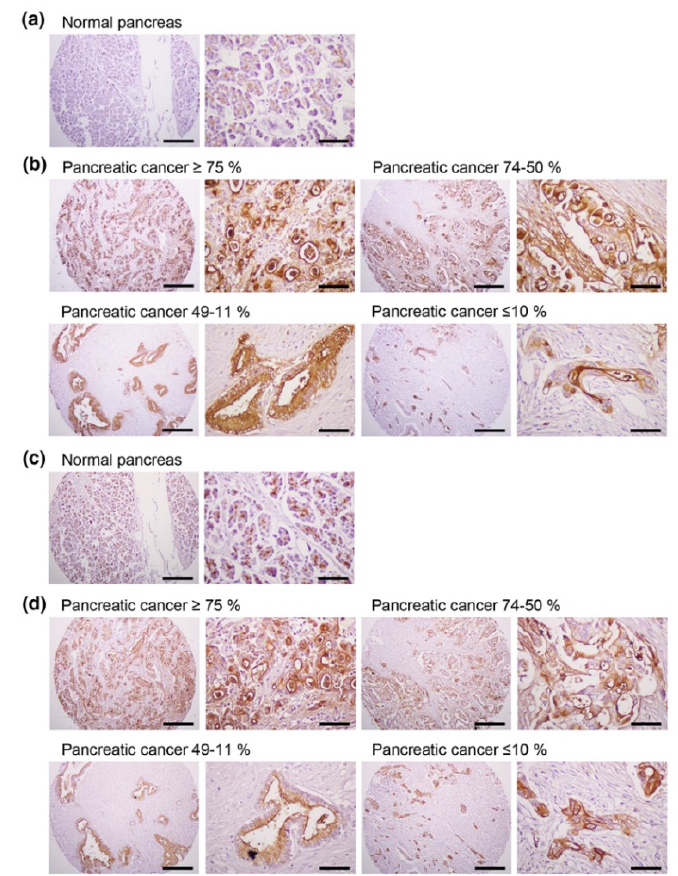
Figure 6. Expression of MUC1 in human pancreatic cancer tissues. Immunohistochemistry of a human pancreatic cancer tissue array was performed with the anti-hMUC1 monoclonal antibody ( a , b ) and anti-MUC1-CT2 antibody ( c , d ). ( a , c ) Normal pancreatic tissue. ( b , d ) Pancreatic cancer tissues with ≥ 75%, 74–50%, 49–11% and ≤ 10% of tumor cells expressing MUC1. Scale bars; left panel, 100 µ m and right panel, 25 µ m.